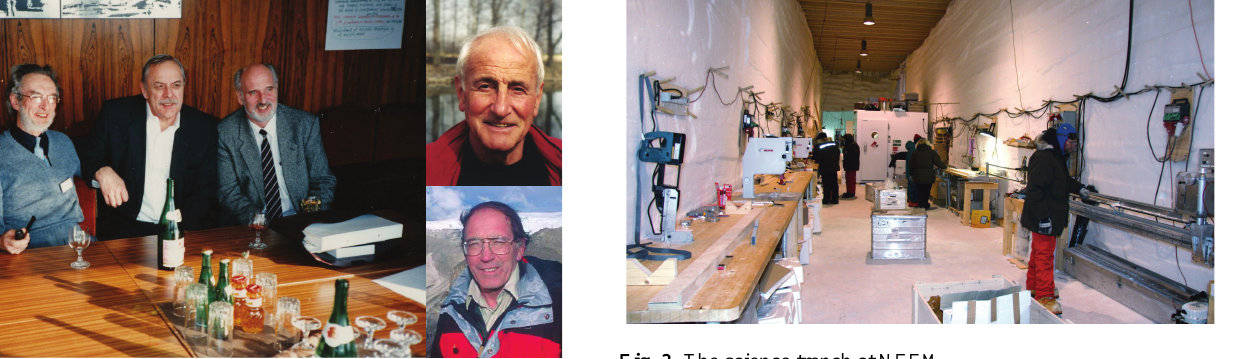
Fig. 2. Some pioneers of ice core research: left panel: Willi Dans- gaard, Chet Langway and Hans Oeschger (from left to right); upper right panel: Claude Lorius; lower right panel: Lonnie Thompson.